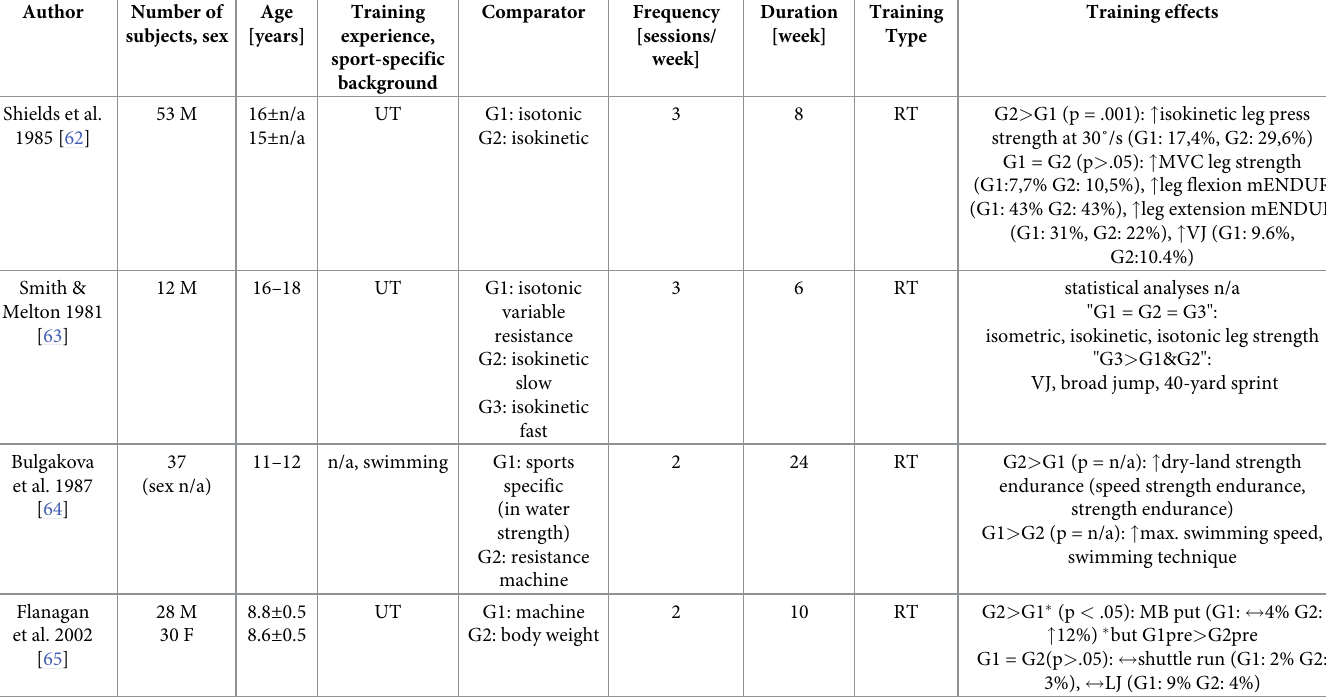
Table 6. Influence of the exercise mode and type on training induced improvements in components of physical